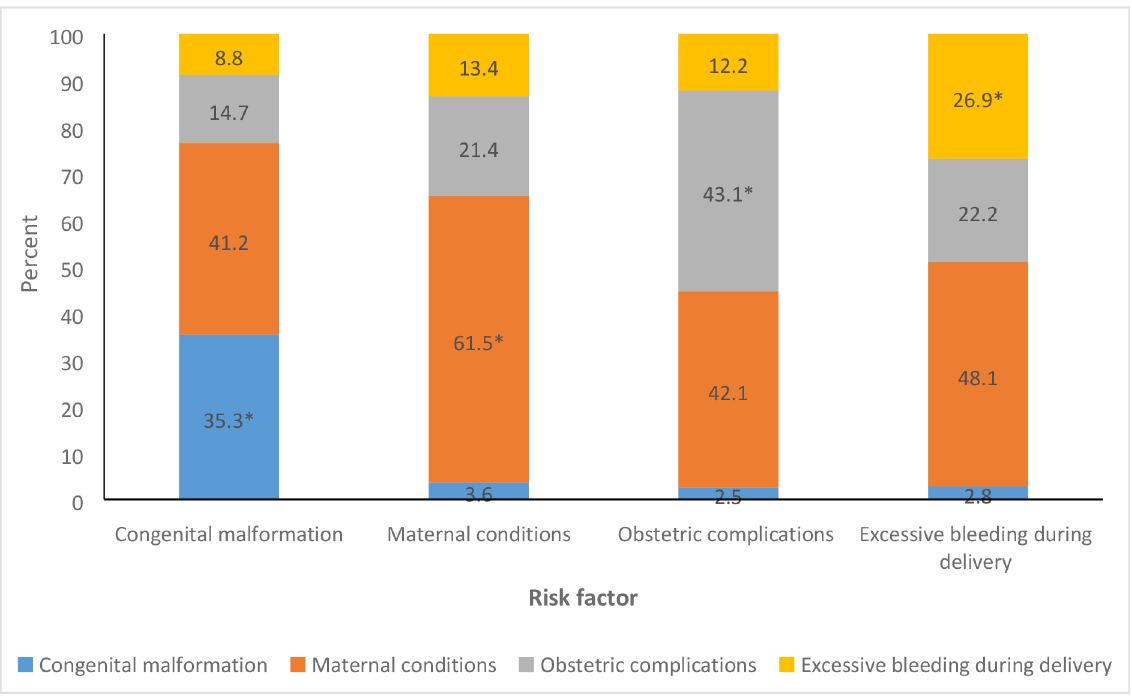
Fig 4. The distribution of the overlap between the various possible risk factors for stillbirth in the Indian state of Bihar. Each bar denotesa risk factor indicatedon the x -axis, and the stacks in each bar denote the overlapwith the other risk factors. * Denotesno overlapwith another risk